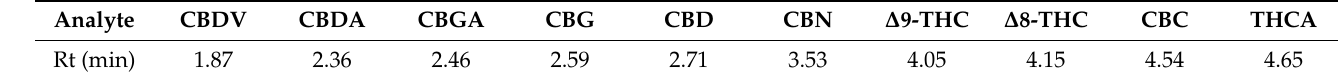
Figure 1. Chromatogram of 10 cannabinoids standard mix (16.7 µg/mL). Table 1. Retention times (Rt) of cannabinoids identified in the standard mix.